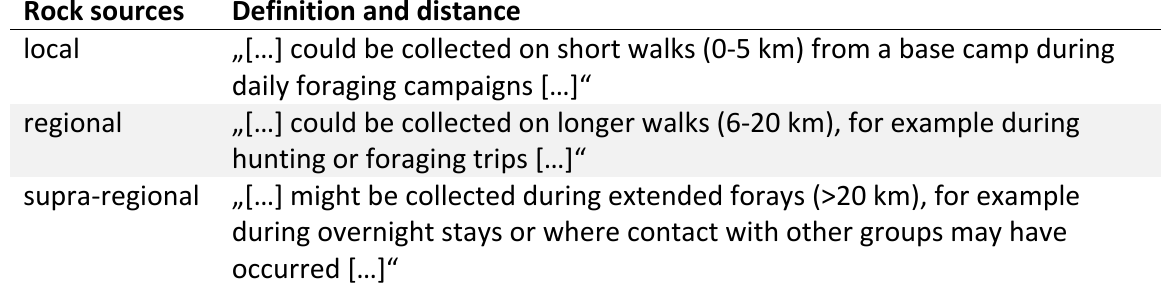
Table 1. Transport distance classification (after Kandel et al . 2016: 636). Rock